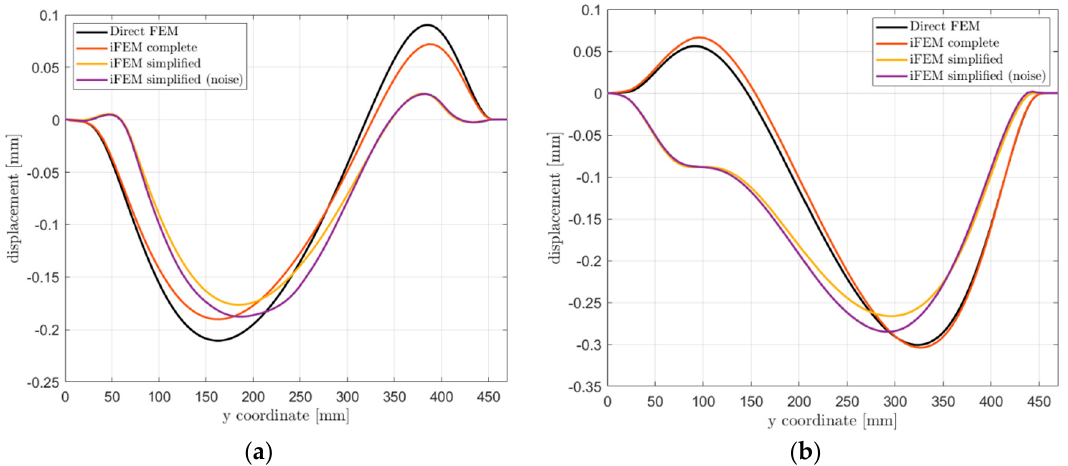
Figure 15. Out-of-plane displacement 𝑼 𝒛 comparison: ( a ) Path 1; ( b ) Path 2.